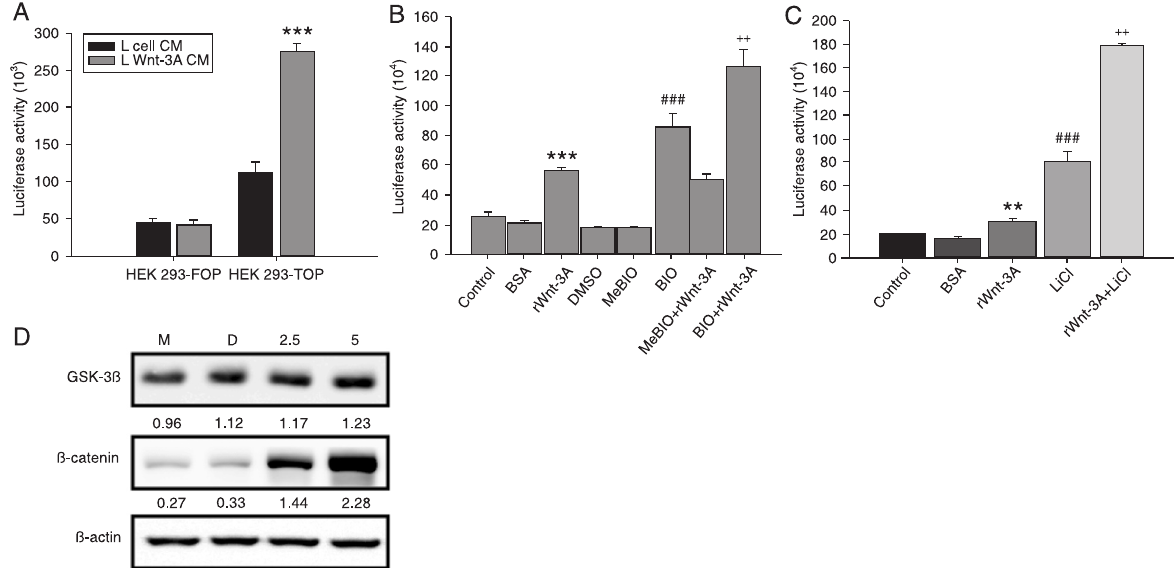
Figure 2. Effects of Wnt-3A proteins on luciferase activities in HEK 293-TOP/FOP stable cells treated or not with BIO or LiCl. A , HEK 293-TOP/FOP cells (1 x 10 4 ) were seeded into a 96-well plate for 24 h and then treated with L cell conditioned medium (CM; control) or 50% (v/v) L Wnt-3A CM for another 24 h. Total cell proteins were collected and subjected to the luciferase assay. ***P < 0.001 vs HEK 293-TOP treated with L cell CM (Student t -test). B and C , HEK 293-TOP cells (1 x 10 4 ) were seeded into a 96-well plate for 24 h. The cells were stimulated or not with rWnt-3A (400 ng/mL) in the presence or absence of BIO (5 μM) or MeBIO (5 μM) or LiCl (20 mM) for 24 h. Total cell proteins were extracted and the luciferase activities were determined. Each bar is the mean ± SD of three independent experiments. **P < 0.01, ***P < 0.001 vs BSA (0.1%) group; ## P < 0.01, ### P < 0.001 vs DMSO (0.1%) or control (medium) group; ++ P < 0.01 vs BIO or LiCl group (Student t -test). D , HEK 293-TOP cells (1 x 10 4 ) were seeded into a 96-well plate for 24 h and stimulated with BIO (2.5 and 5 μM) for another 24 h. Finally, total cell proteins were extracted and subjected to Western blotting. The ratios of β-catenin or GSK-3β to β-actin proteins are shown in the bottom panel. BIO = (2’ Z ,3’ E )-6-bromoindirubin-3’-oxime. Lane M = medium; lane D = DMSO